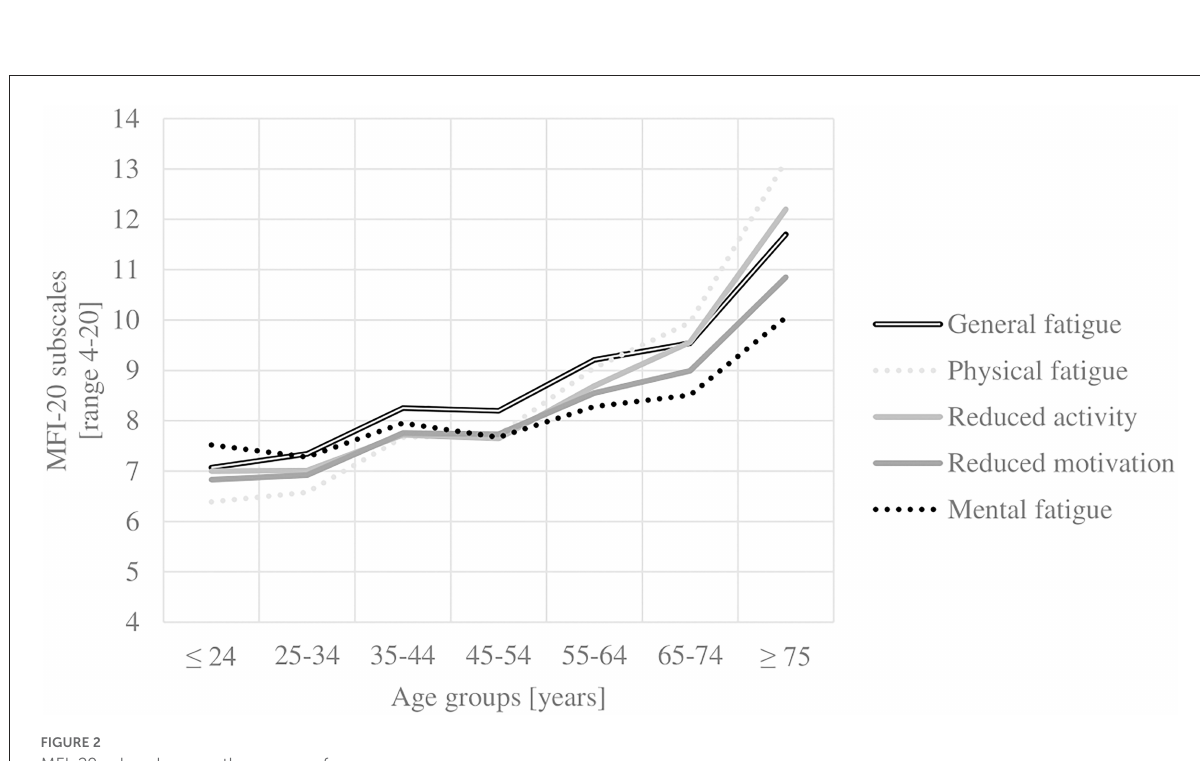
FIGURE2 MFI-20 subscales over the course of